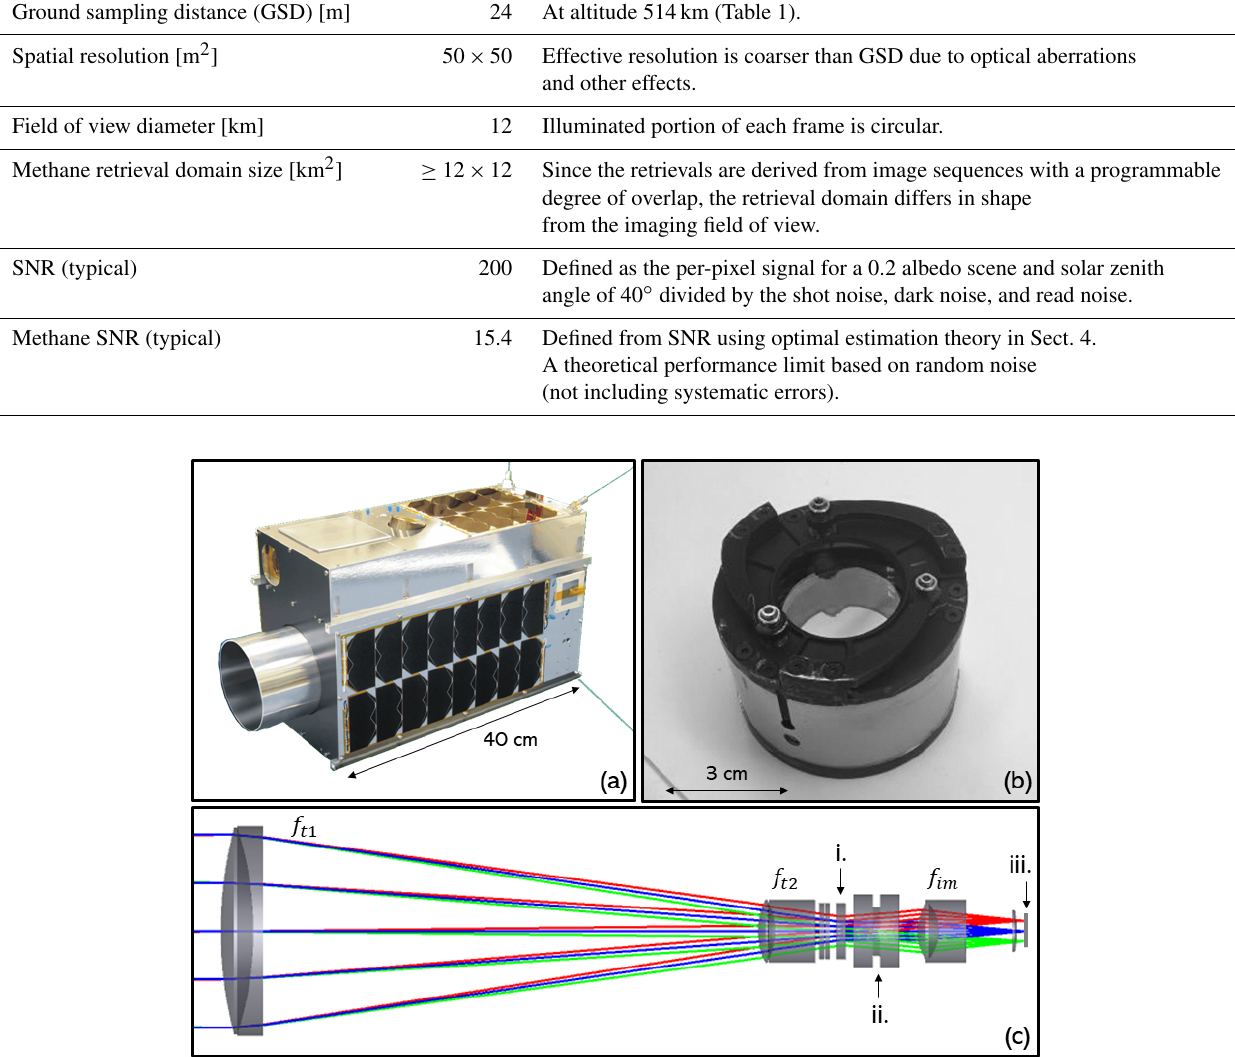
Figure 2. (a) The GHGSat-D spacecraft with the imaging spectrometer on board. (b) The mounted Fabry–Pérot interferometer. (c) Schematic of the unfolded optical system with the (i) OSF, (ii) F–P, and (iii) detector identified. The red, blue, and green rays originate from different ground